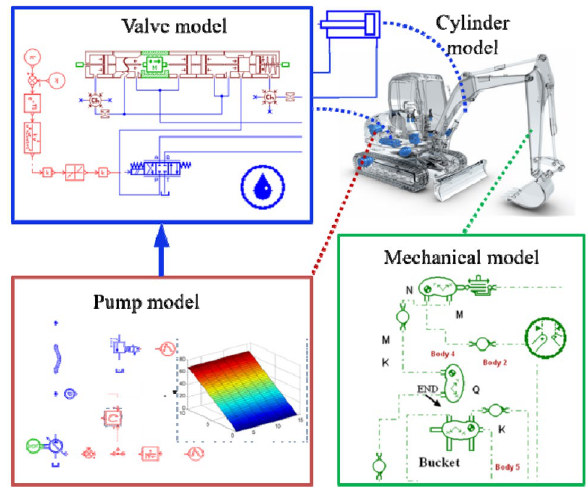
Figure 17 Simulation model in the AMESim Environment